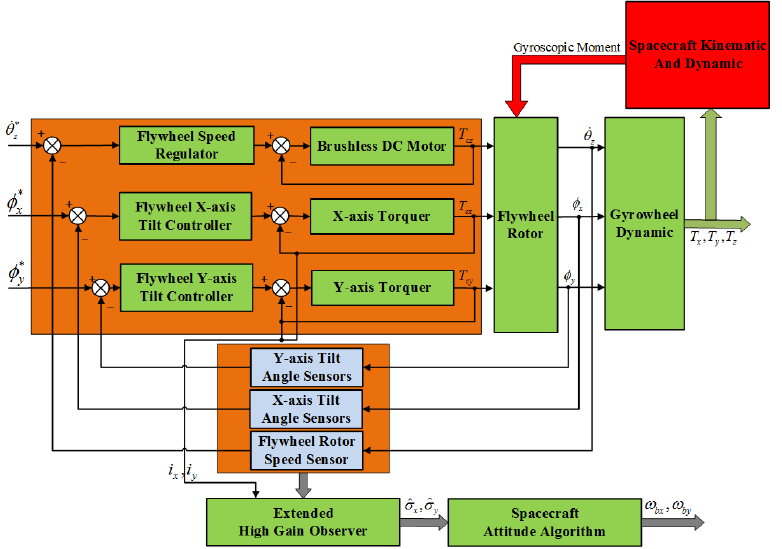
Figure 5. The changes of the extremum of estimation error.